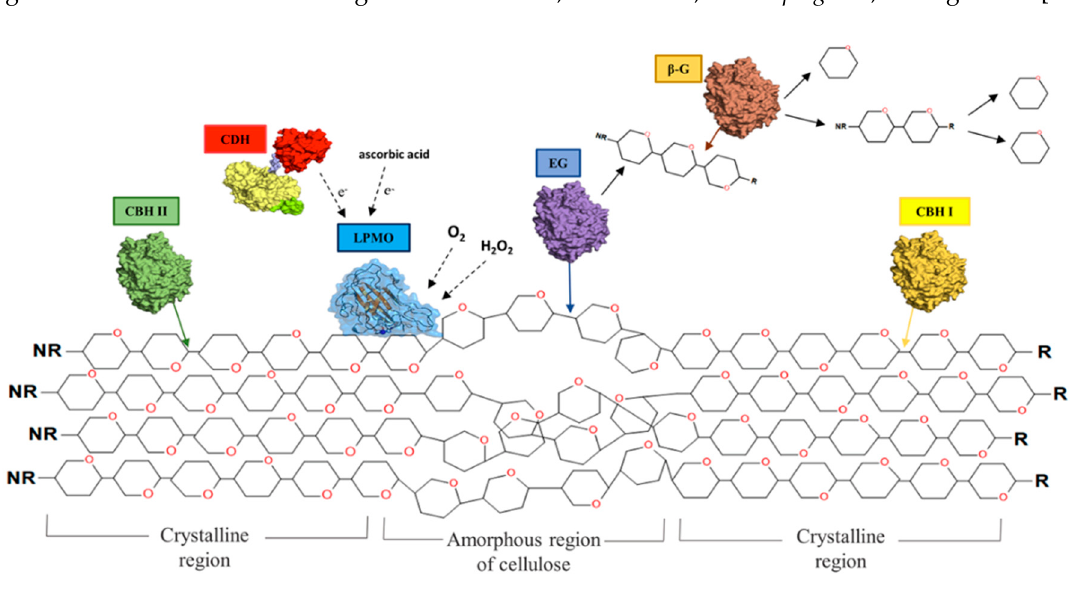
Figure 3. Overall schematic representation of the mechanisms involved in NC production by distinct classes of enzymes (adapted from [72]). R: reducing cellulose end; NR: nonreducing cellulose end;